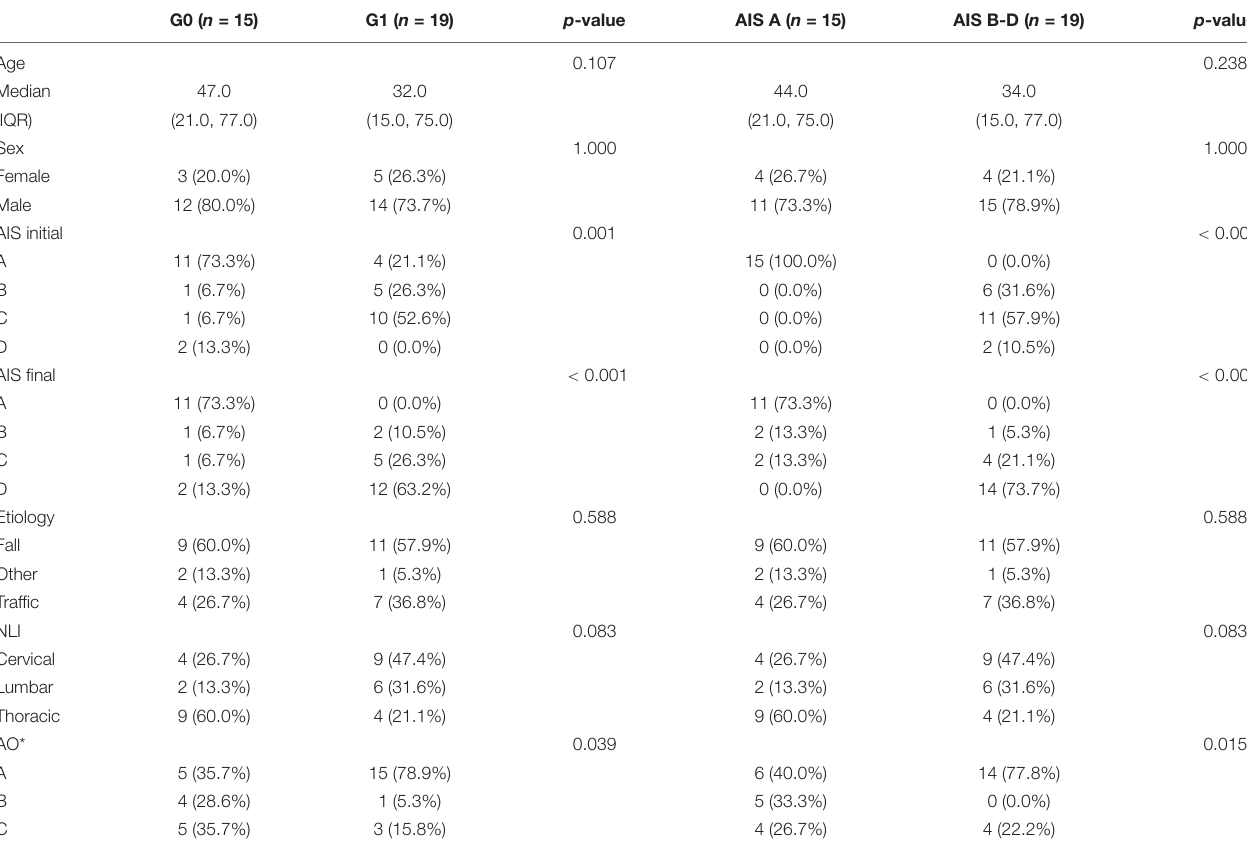
TABLE 2 | Clinical characteristics of subjects in the groups G0 ( n = 15) and G1 ( n = 19), and subgroups AIS A ( n = 15) and AIS B-D ( n = 19).